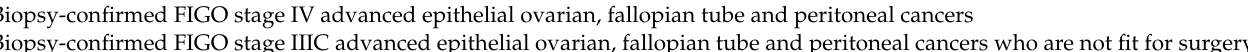
Table 3. Decision-making criteria for use of